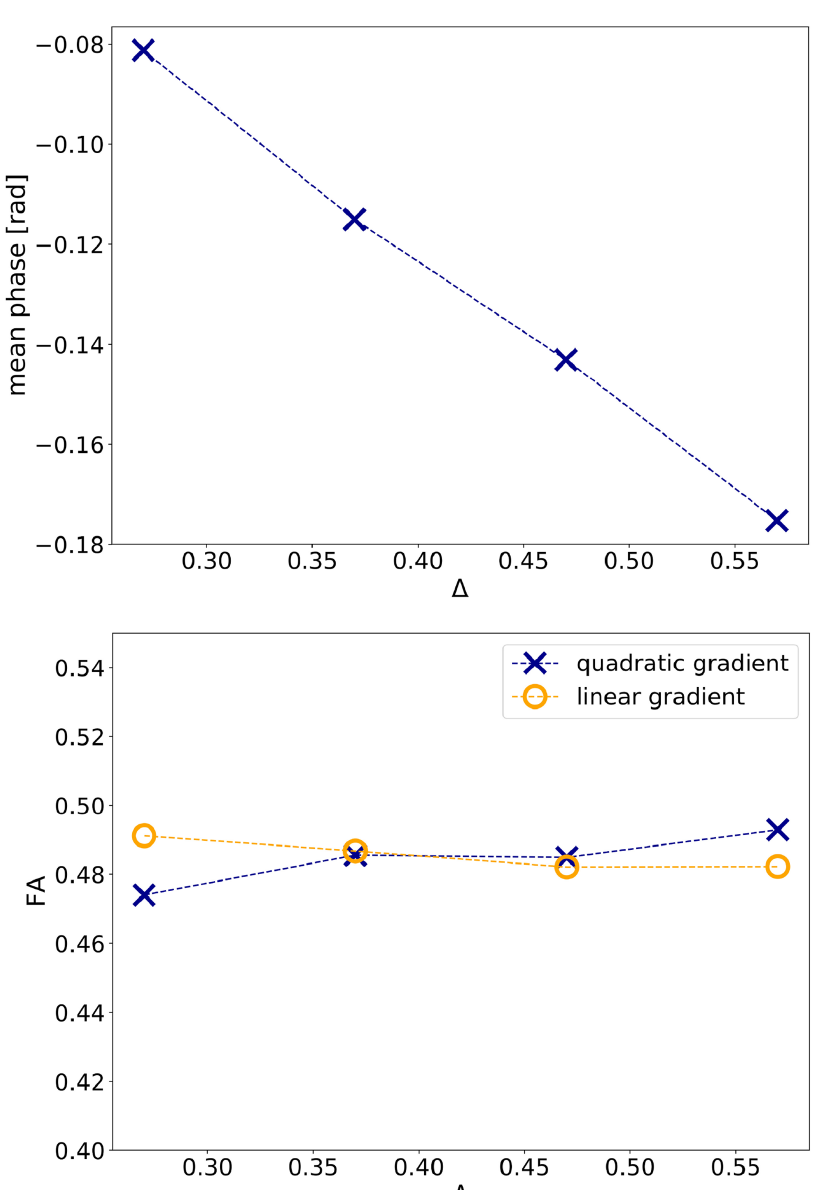
Fig 6. The results of the numerical fibre phantom experiment B2: The mean net phase (top) and FA (bottom) versus the separation time Δ between the two diffusion gradient pulses.